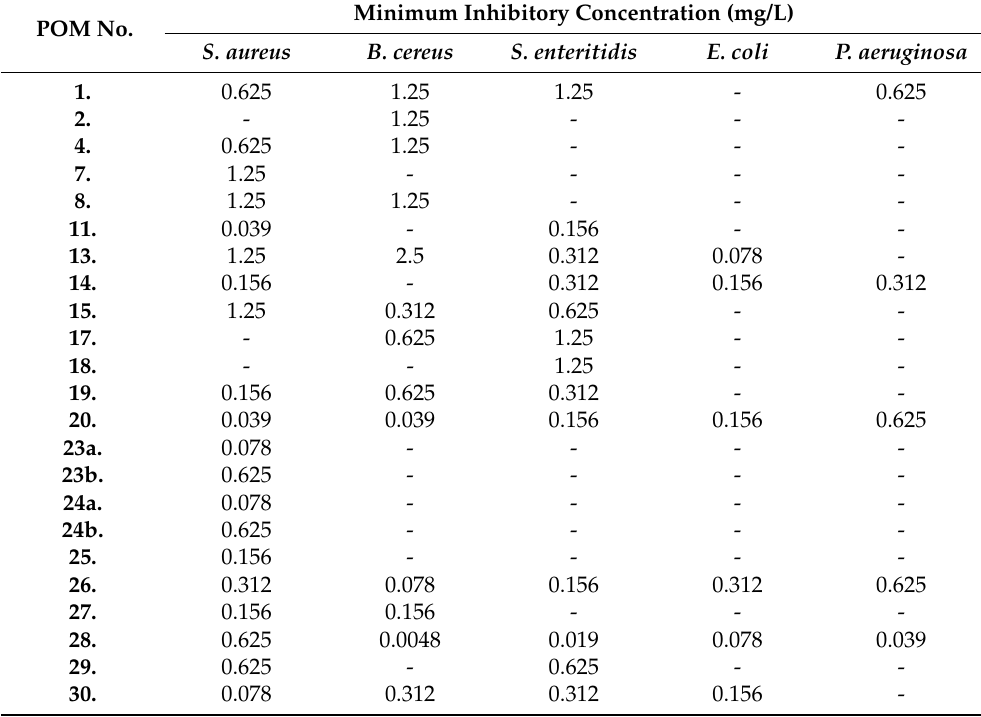
Table 4. Minimum inhibitory concentration of active POMs.